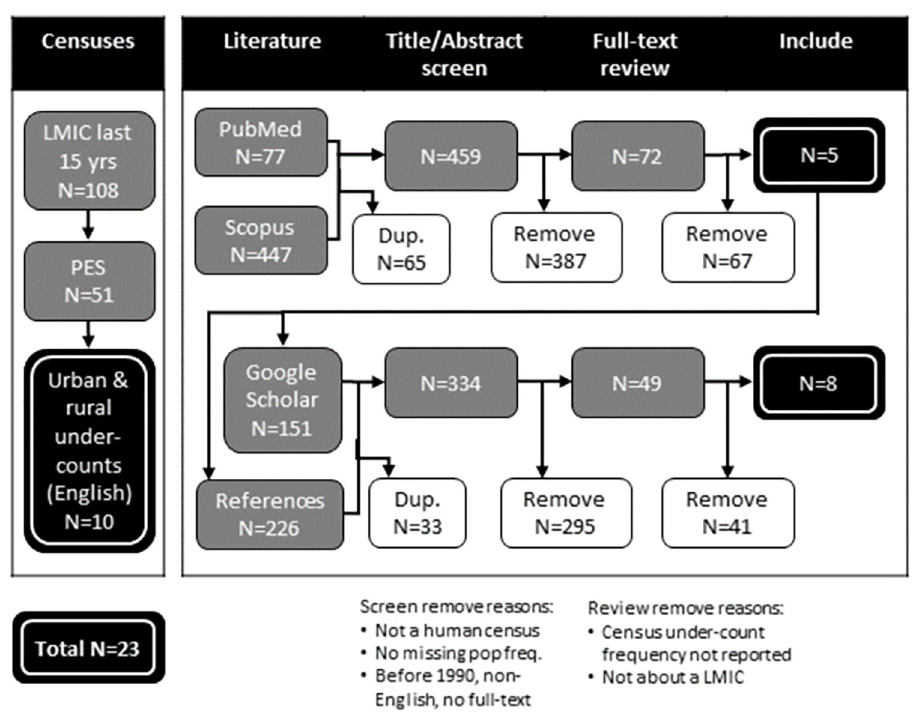
Fig 4. Search terms and process used in the census under-count literature